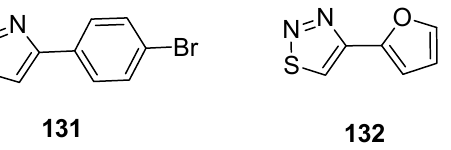
Figure 23. The most active antiamoebic 1,2,3-thiadiazoles 131 and 132.